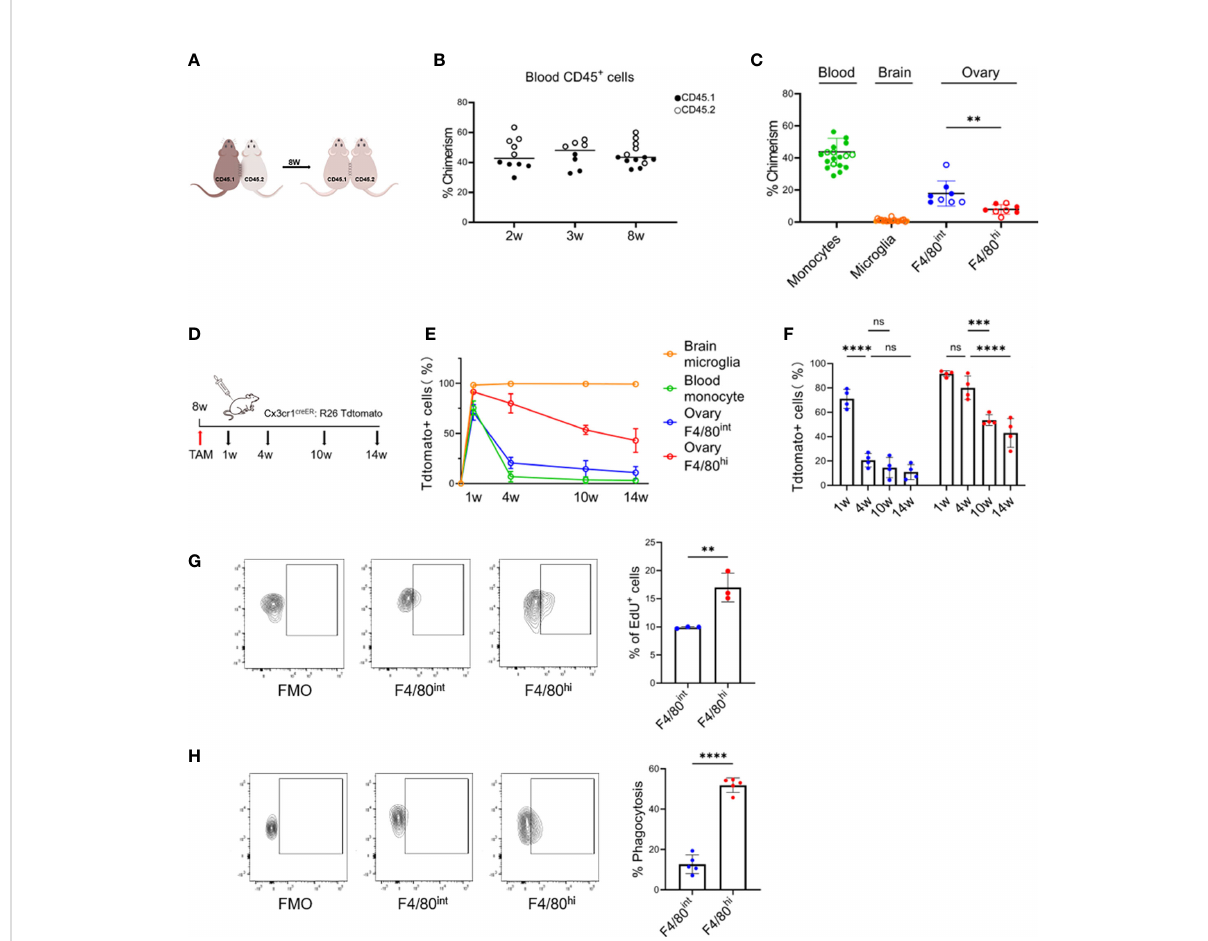
FIGURE 3 Tissue-resident and self-maintaining characteristics of the two macrophage subsets in the ovary. (A) Parabiosis experimental design. (B) Percent chimerism among host immune cells in blood from parabiotic chimeras (n=8~14, Mean ± SEM). (C) Chimeric ratios of monocytes, microglia, and two subpopulations of macrophages in the ovary (for the ovarian data, each dot represents data from 4 individual mice pooled together, while for the data of blood and brain, each point represents one mouse. Mean ± SEM). (D) Fate mapping experimental design. (E) Changes in the proportion of Tdtomato + cells with time in the different populations. (F) Quanti fi cation of Tdtomato-labeling in two subsets of ovarian macrophages (n=4. Mean ± SEM). (G) EdU + cells gating strategy and the percentage of proliferating EdU + cells after 24 hours of pulse-labeling (n=3. Mean ± SEM). (H) Uptake of intravenously administered fl uorescent E. coli BioParticles by two macrophage subpopulations in the ovary. (n=4. Mean± SEM). ns, no signi fi cance, **P < 0.01, ***P < 0.001, ****P <